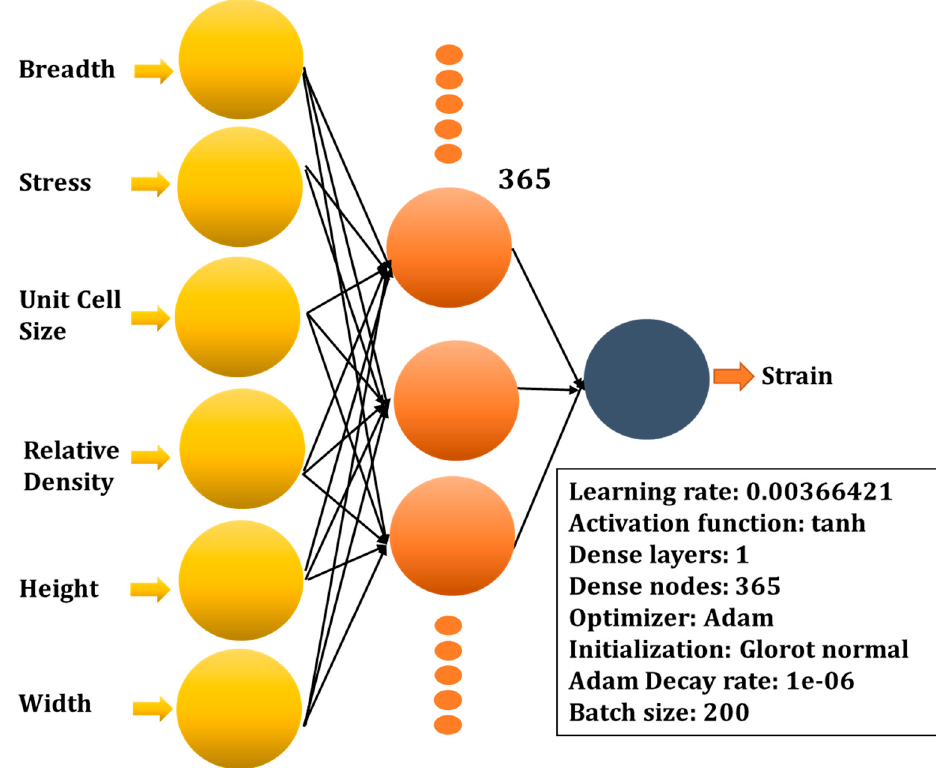
Figure 4. Framework of the optimal DL